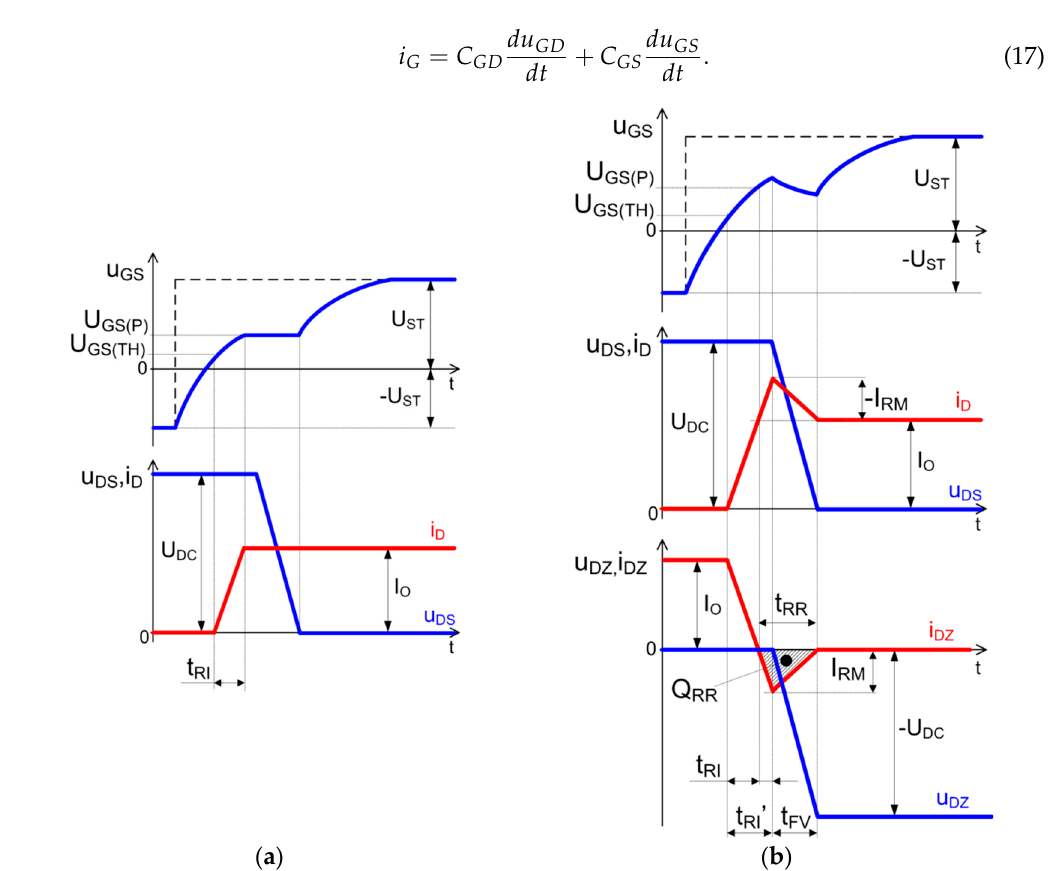
Figure 7. Voltage and current waveforms in a basic switching cell during transistor turn-on process: ( a ) without the diode D Z reverse recovery; ( b ) with the diode D Z reverse recovery.